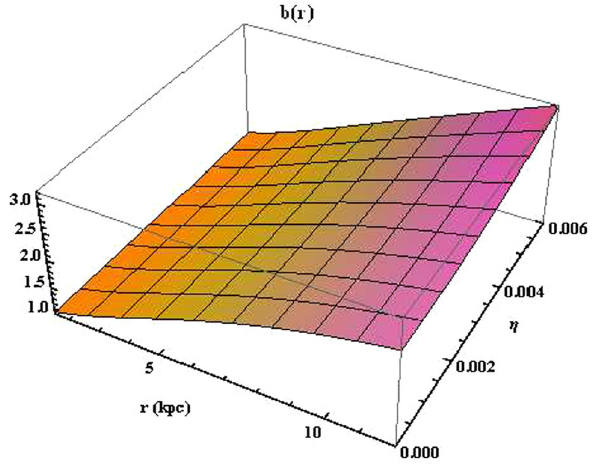
Fig. 1 The density is plotted with respect to the radial coordinate r corresponding to the parameters ρ 0 = 0 . 004 kpc − 2 ,α = 0 . 5 and r 0 = 2 kpc